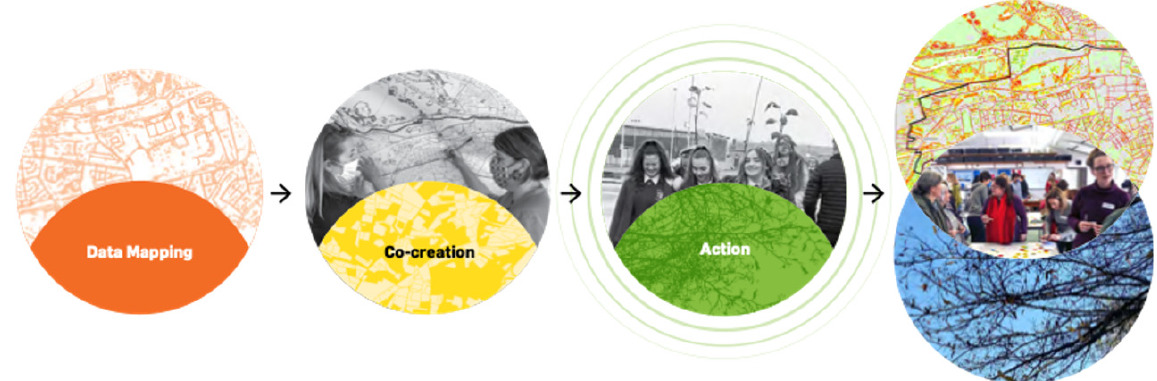
Figure 1. MGD project structure. to the community recommendations from the co‐ creation stage. A community‐based urban green‐ ing strategy was created and included a set of pathways to enhanced greening at neighbour‐ hood level.